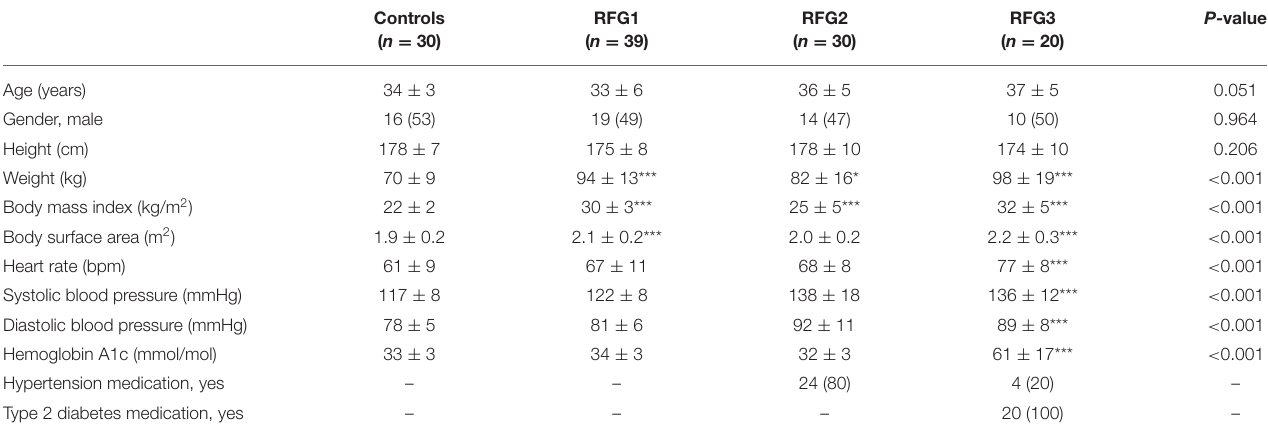
TABLE 1 | Clinical characteristics of controls and risk factor groups (RFG). Controls RFG1 RFG2 RFG3